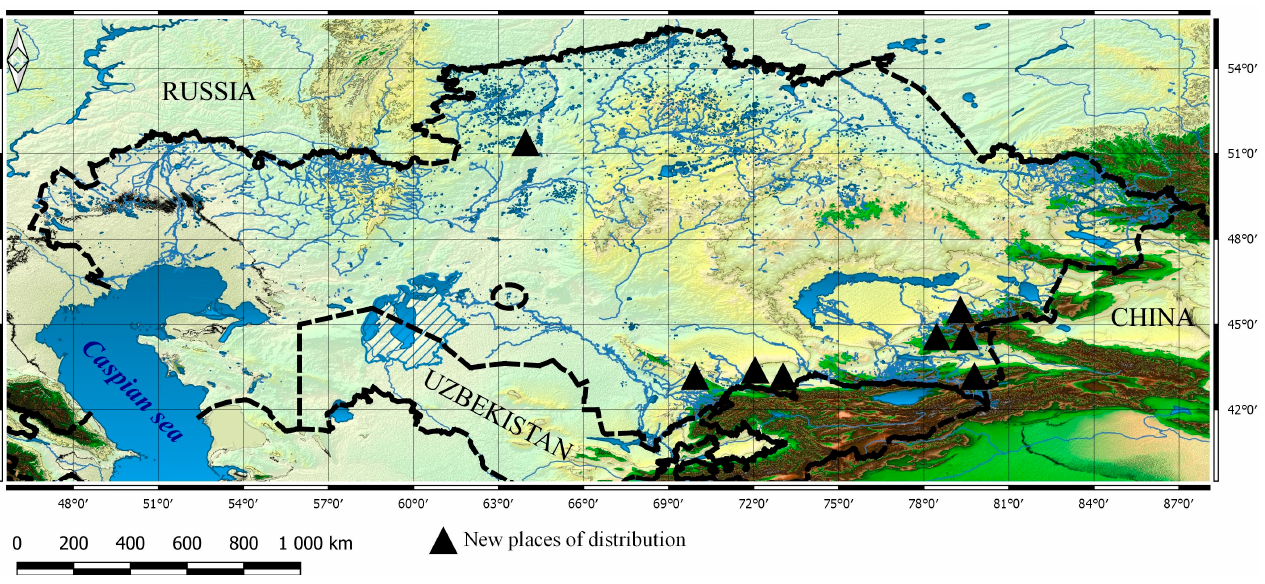
Figure 5. Distribution of Dactylorhiza salina (Turcz. ex Lindl.) Soó in Kazakhstan. 3.2.3. Dactylorhiza umbrosa (Kar. and Kir.) Nevski, Tr. Bot. Inst. Ac. Sci. USSR, Ser. 1,4: Turgai: Turgai hollow, northern part of the Naurzum pine forest, wet meadow near the outlet of the Ugen-Blyash stream, 22.VI.1960, Gorelov (MW!). Dzungarian Alatau: Altyn-Emel mountains, southern spurs, Tyulkum and Tyulkuli gorges, along the western slope of grass, 23.VI.1971, L. Yanchenko (LE!); Toksanbay ridge, southern slopes, the upper reaches of the Small Usek river, near the shore, 20.VI.1937, N.I. Rubtsov (AA!); Dzungarian Alatau, southern slope, the upper reaches of the Karatal river, east of the village of Karabulak, a wet peat meadow near a stream, 4.VII.1928, N.V. Shipchinsky